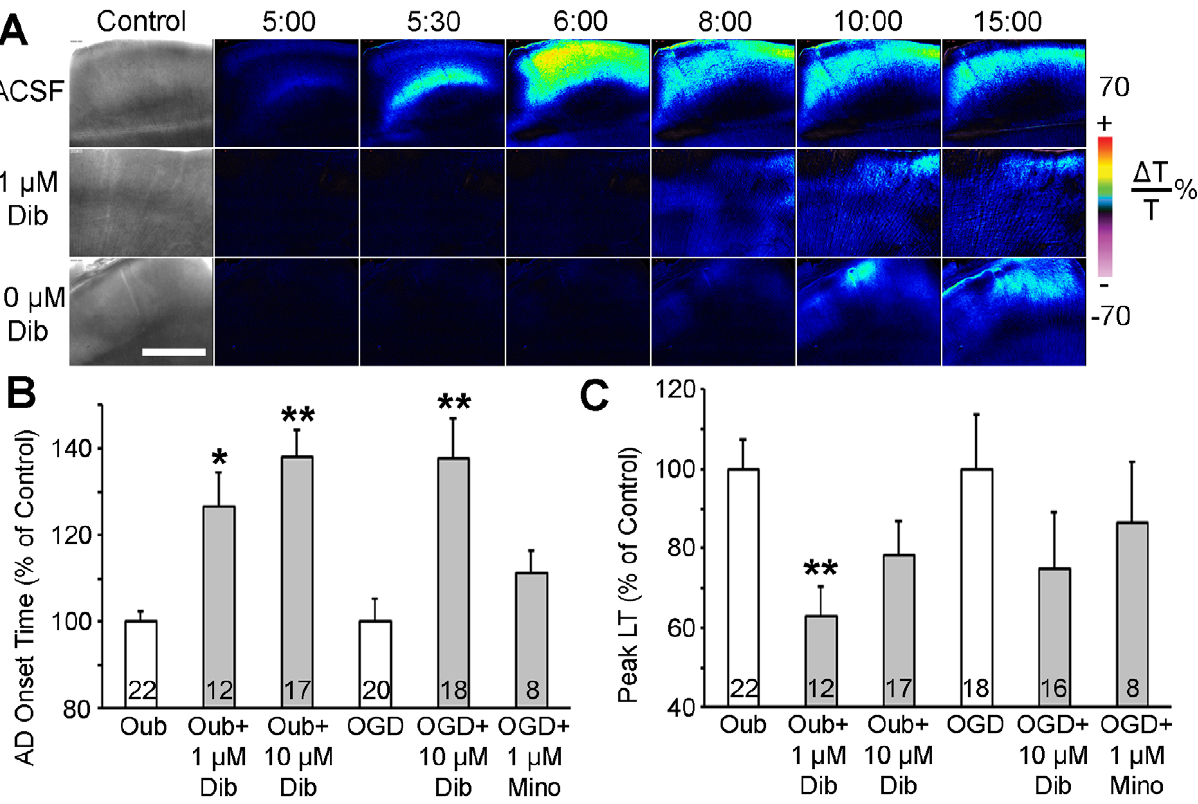
Figure 2. Dibucaine pretreatment delays terminal depolarization in human neocortical slices. A , Changes in LT ( D LT) are utilized to track terminal depolarization in real time. The first image in each row shows bright field image of the slice. A control untreated slice incubated in standard ACSF (top row) undergoes terminal depolarization within 5 minutes of superfusion with 100 m M ouabain. Pseudocolored elevated D LT indicates cell swelling. In slices pretreated with either 1 or 10 m M dibucaine for 60 min (middle and bottom rows, respectively), ouabain-induced terminal depolarization is delayed by 2.1 and 4.8 min respectively and has less impact in terms of cell swelling. All three slices were from the same patient ( # 7; see Patient Table S1). Scale bar, 1 mm. B , Pretreatment for 1 hour with dibucaine significantly increases the latency to terminal depolarization onset induced by 100 m M ouabain or OGD when compared to untreated control slices from the same patient. C , Peak cell swelling during terminal depolarization in the same slices pretreated with dibucaine. The neuroprotective anti-inflammatory drug minocycline had no effect on terminal depolarization. Numbers of slices in each condition are indicated within each bar. Values are shown as percent of control (untreated slices from the same patient). Asterisks indicate significant differences from control (* p , 0.05, ** p , 0.001, two-way